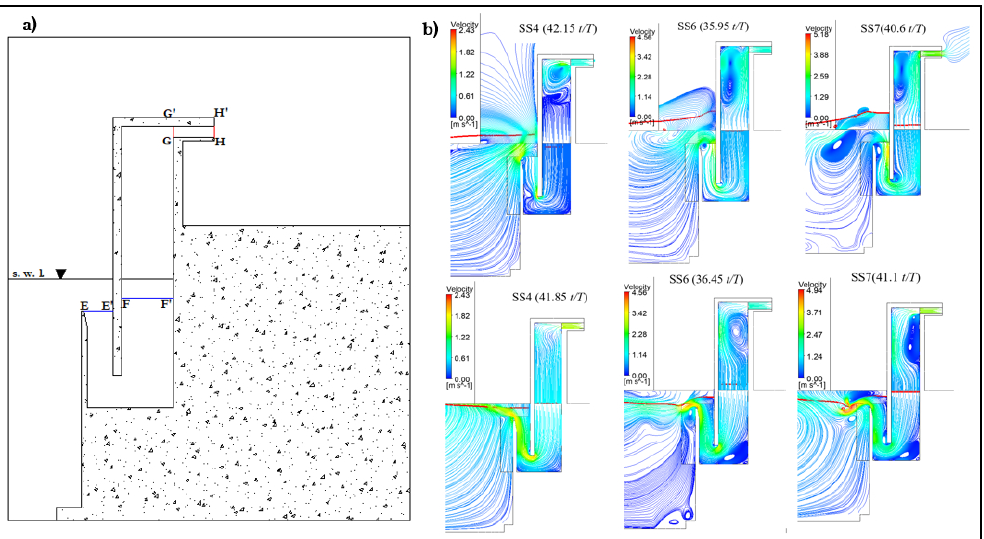
Figure 13. ( a ) Reference scheme for the evaluation of the energy flux in sections EE (cid:48) , FF (cid:48) , GG (cid:48) and HH (cid:48) ; ( b ) streamline of velocity for each of wave train